Question: Compose a caption that would accompany this figure in a paper.
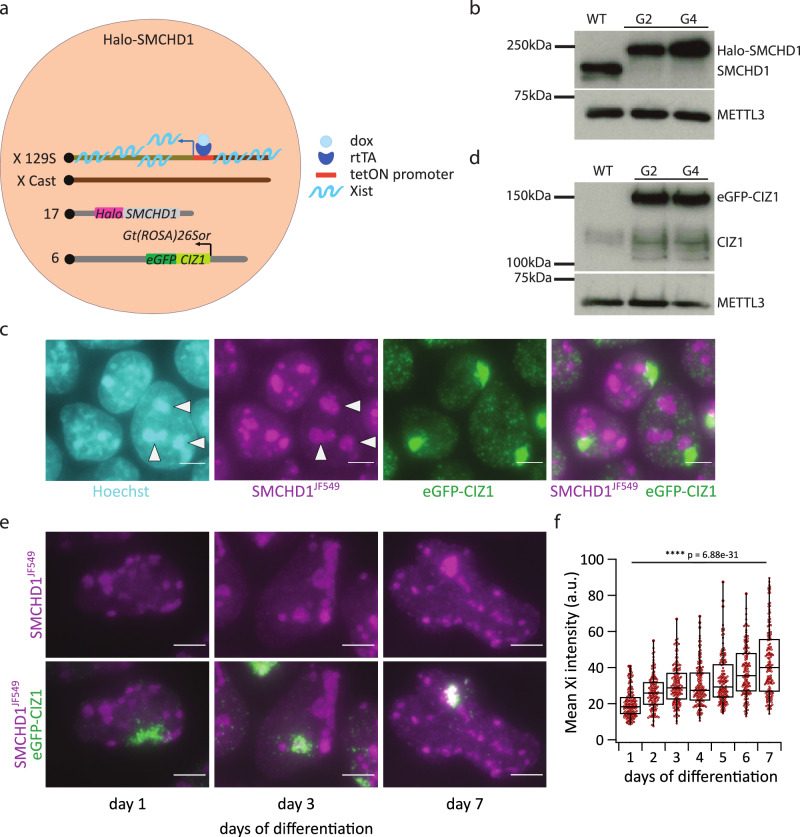
Answer: A model system to analyse dynamic interactions of SMCHD1 with chromatin. a Schematic of the Halo-SMCHD1 XX mESC line generated in the iXist-ChrX mESC line. b Western Blot showing the level of expression of Halo-SMCHD1 in two independent clones. Clone G2 was used for further experiments. METTL3 loading control c Representative live-cell images of Halo-SMCHD1 mESC line, taken after 24 h doxycycline addition. Arrowheads indicate selected PCH domains. Images are maximum-intensity projections, scale bar - 5 µm. (three independent replicates) d Western blot showing the expression of eGFP-tagged CIZ1 in two independent clones. METTL3 loading control e Representative live-cell images showing gradual accumulation of SMCHD1 over the Xi domain marked by eGFP-CIZ1 during mESC differentiation. Images are maximum-intensity projections, scale bar - 5 µm. f Quantification of SMCHD1 signal underlying the CIZ1 domain at each day during a 7-day live-cell imaging differentiation timecourse. Each dot represents a single cell, n = 136-159. Boxplots: centre lines indicate the median, box limits indicate the first and third quartiles, and whiskers extend to min/max data points. Statistical analysis was performed by a two-sided unpaired t-test. Source data are provided as a Source Data file.